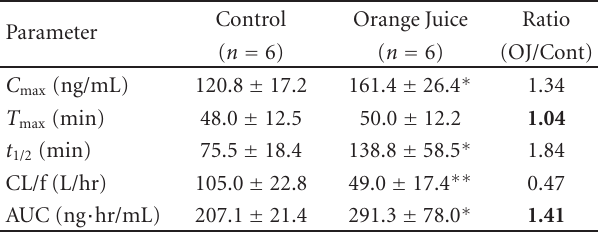
Table 1: E ff ect of orange juice on the pharmacokinetic parameters of single-orally administrated pravastatin on rats.